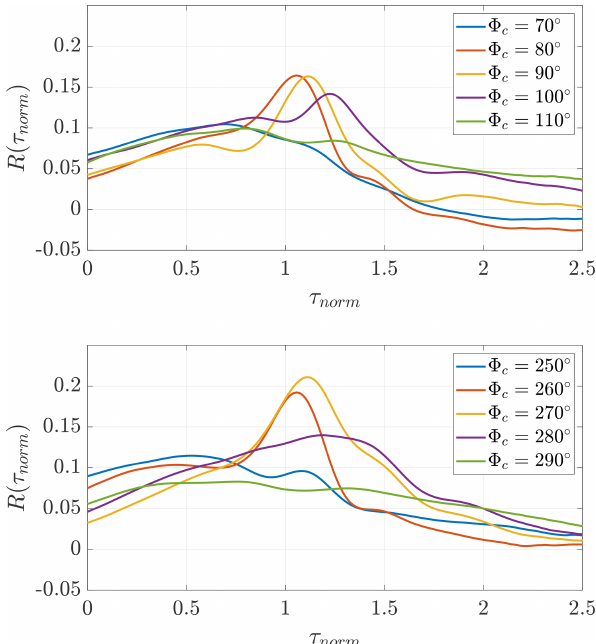
Figure 4. Average power output fluctuation correlations for wind direction intervals from around 70 to 110 ◦ and around 250 to 290 ◦ as radial cuts through Fig. 3. (cid:56) c depicts the centre of the wind di- rection intervals.